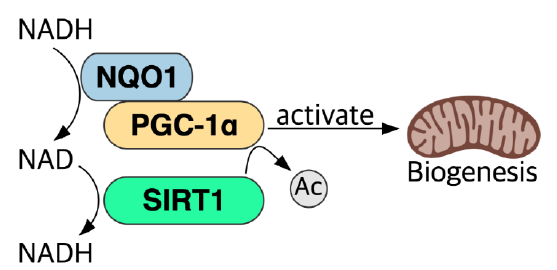
Figure 3. NQO1 cooperates with SIRT1 to activate PGC-1 α . NQO1 binds to PGC-1 α in an NADH- dependent manner, and SIRT1 activates PGC-1 α via the removal of an acetyl group from PGC-1 α using NAD + .